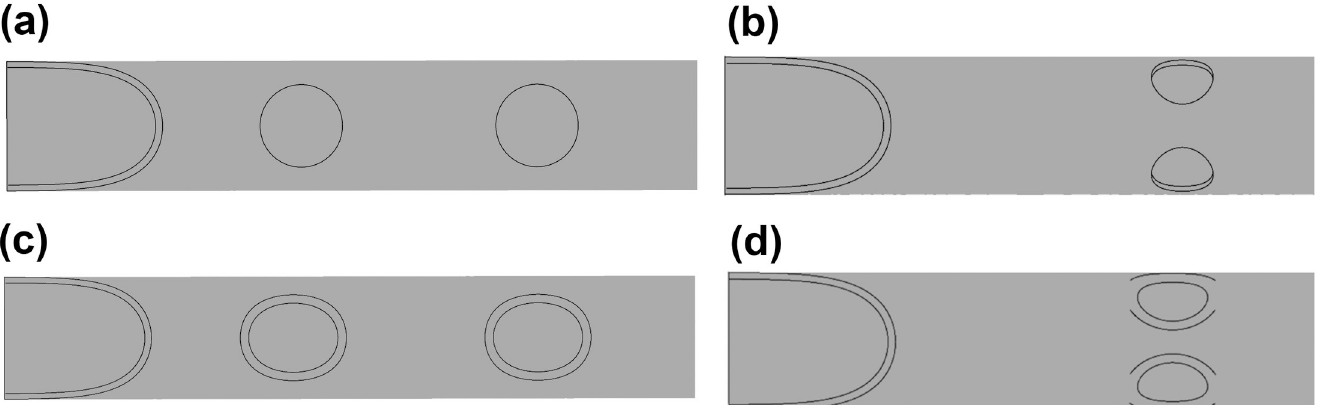
Fig 3. Linear (a,c) and Parallel (b,d) dual-hole configurations for the circular and oval holes.